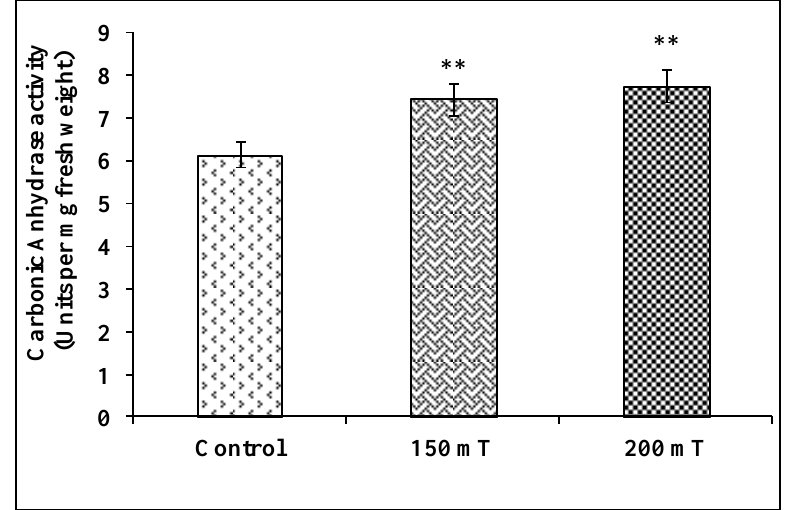
Figure 9. Effect of pre-sowing magnetic field treatment of soybean seeds on carbonic anhydrase activity. ** indicates significance at p < 0.01 compared to control.